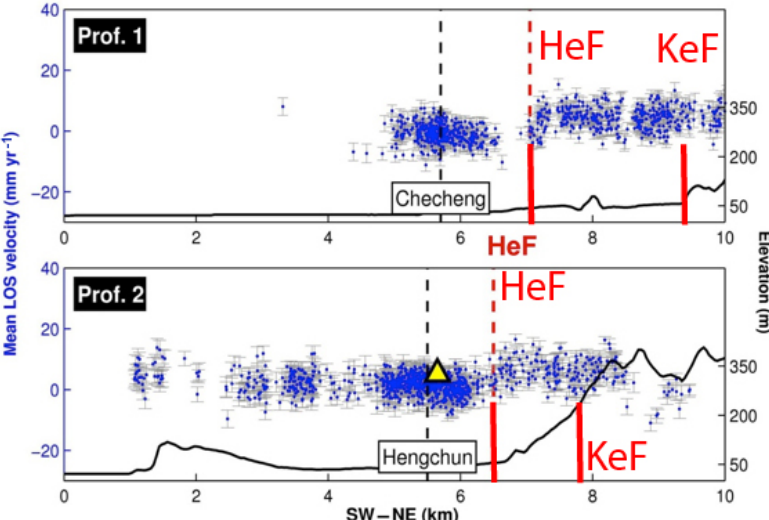
Figure 11. E–W projection of mean LOS velocity in mmyr − 1 (blue dots with error bars, E on the right) on two profiles transverse to the northern part of Hengchun Valley (close to the cities of Checheng and Hengchun; see profile location in Fig. 9). Black line: topography; yel- low triangle: GPS point; HeF: Hengchun Fault; KeF: Kenting Fault. Note that Figs. 10 and 11 both show similar topographic displacements: the LOS offsets close to 10 ± 2.5mmyr − 1 associated with the Kenting Mélange uplift east of the Hengchun Fault, which contrasts with the generally subsiding Hengchun Valley. Kenting Fault has no vertical interseismic offset during the monitoring time period.